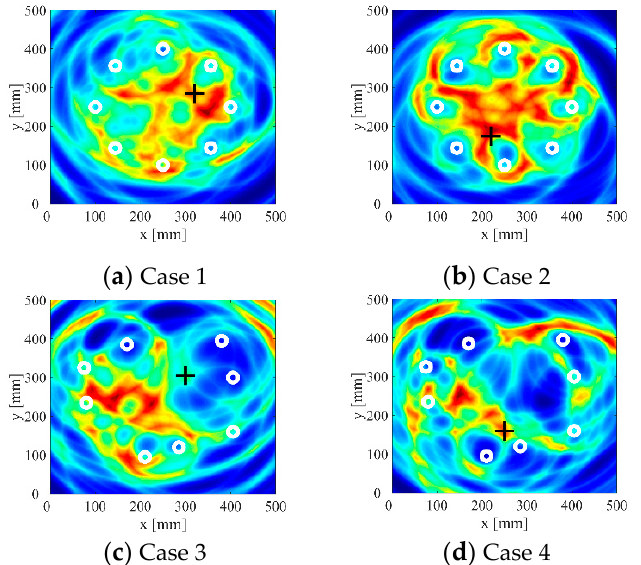
Figure 11. Imaging results of traditional probabilistic ellipse imaging algorithm. (The white circles are the sensor locations, and the black crosses are the actual locations of the defect.)